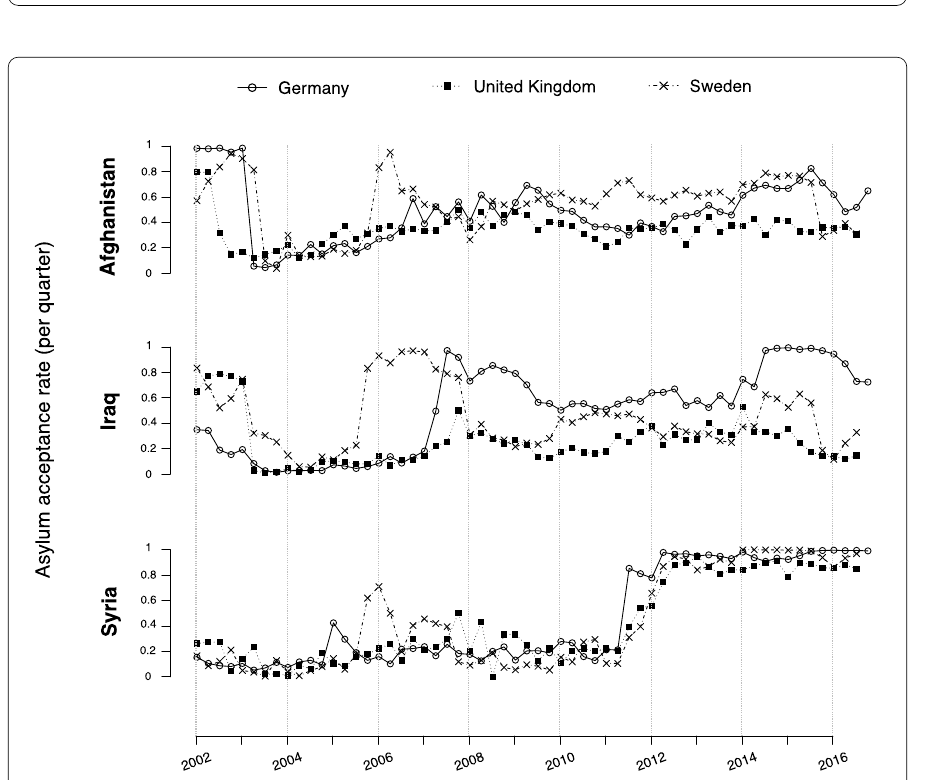
Figure 3 Time evolution of asylum acceptance rates. Time evolution of asylum acceptance rates in Germany, the UK, and Sweden for three asylum seekers’ countries of origin: (top) Afghanistan, (middle) Iraq, and (bottom)